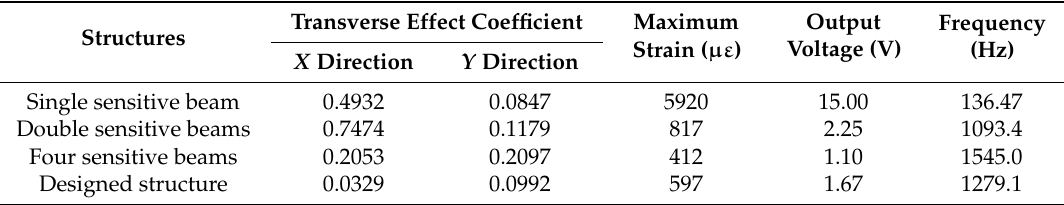
Table 2. Comparison of the